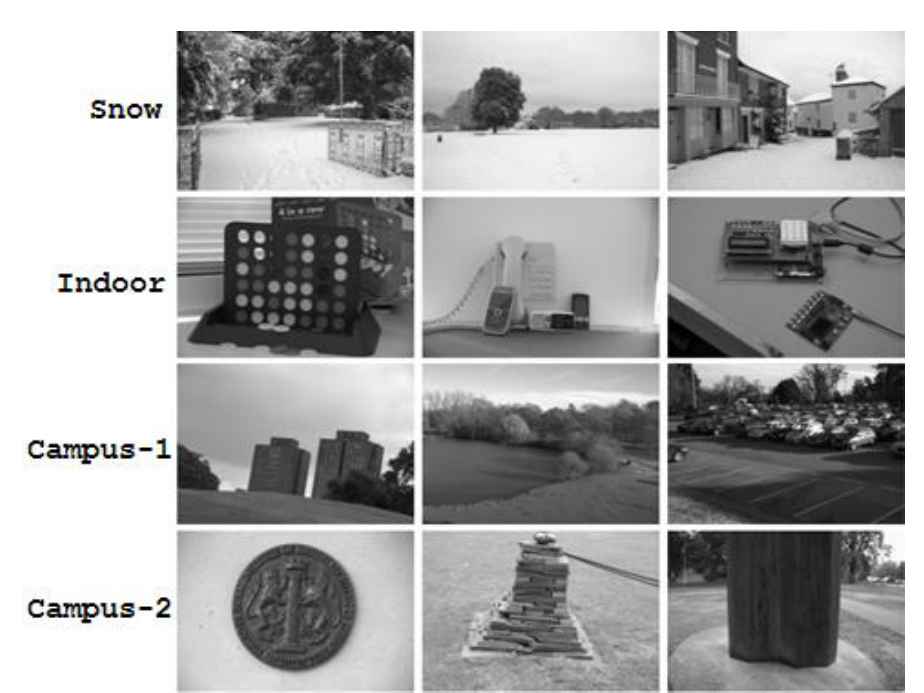
Figure 6. Some images from the Snow, Indoor, Campus-1 and Campus-2